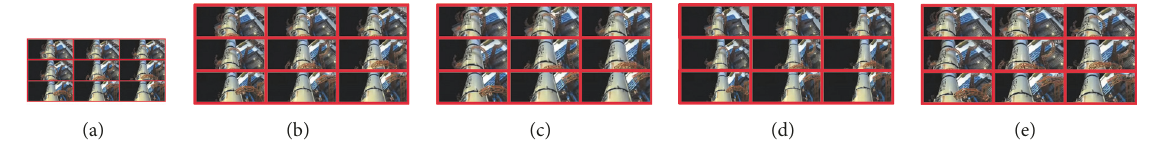
Figure 10: Comparison results of sequence S7 using four methods when the resolution is resized from 320×145 to 500×230 . (a) The original frames, (b) scaling, (c) the best cropping, (d) ISC, and (e) PTDS.